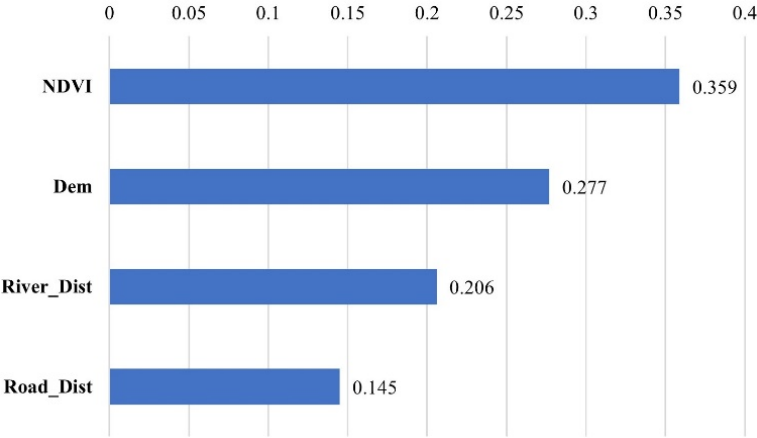
Figure 8. Impact factor contributions. The vertical coordinates River_Dist and Road_Dist indicate the Euclidean-distance assessment for roads and rivers.